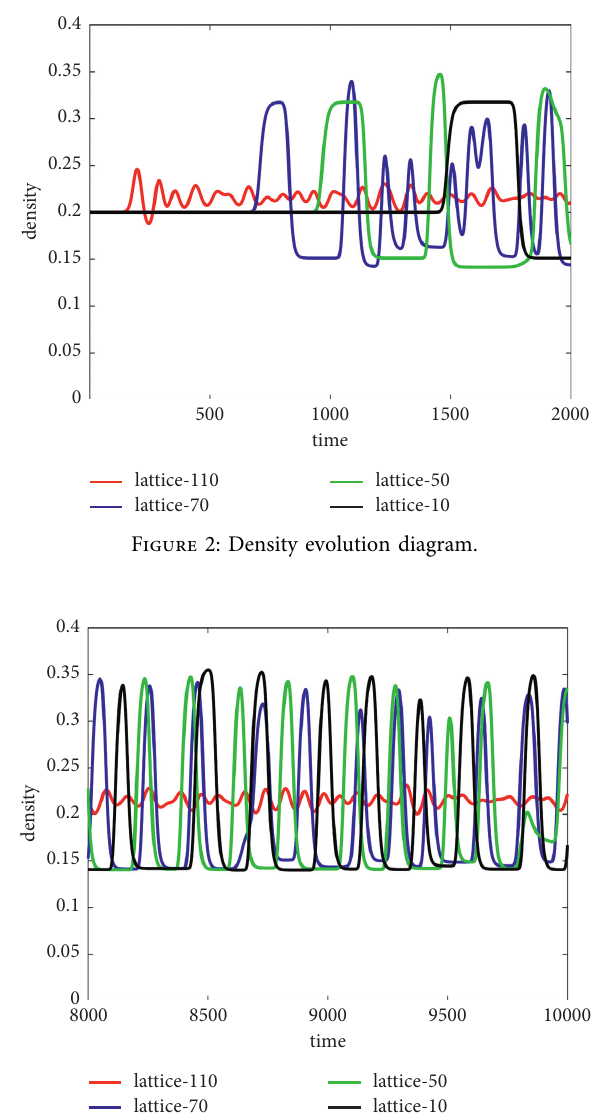
Figure 3: Density evolution diagram.